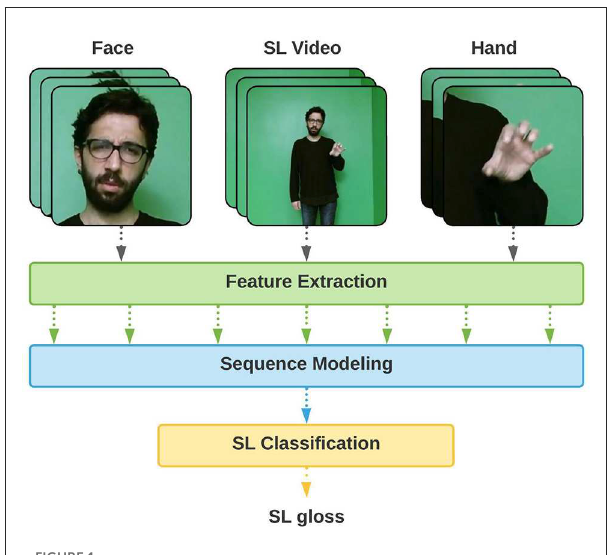
FIGURE1 Multi-cue isolated sign language recognition